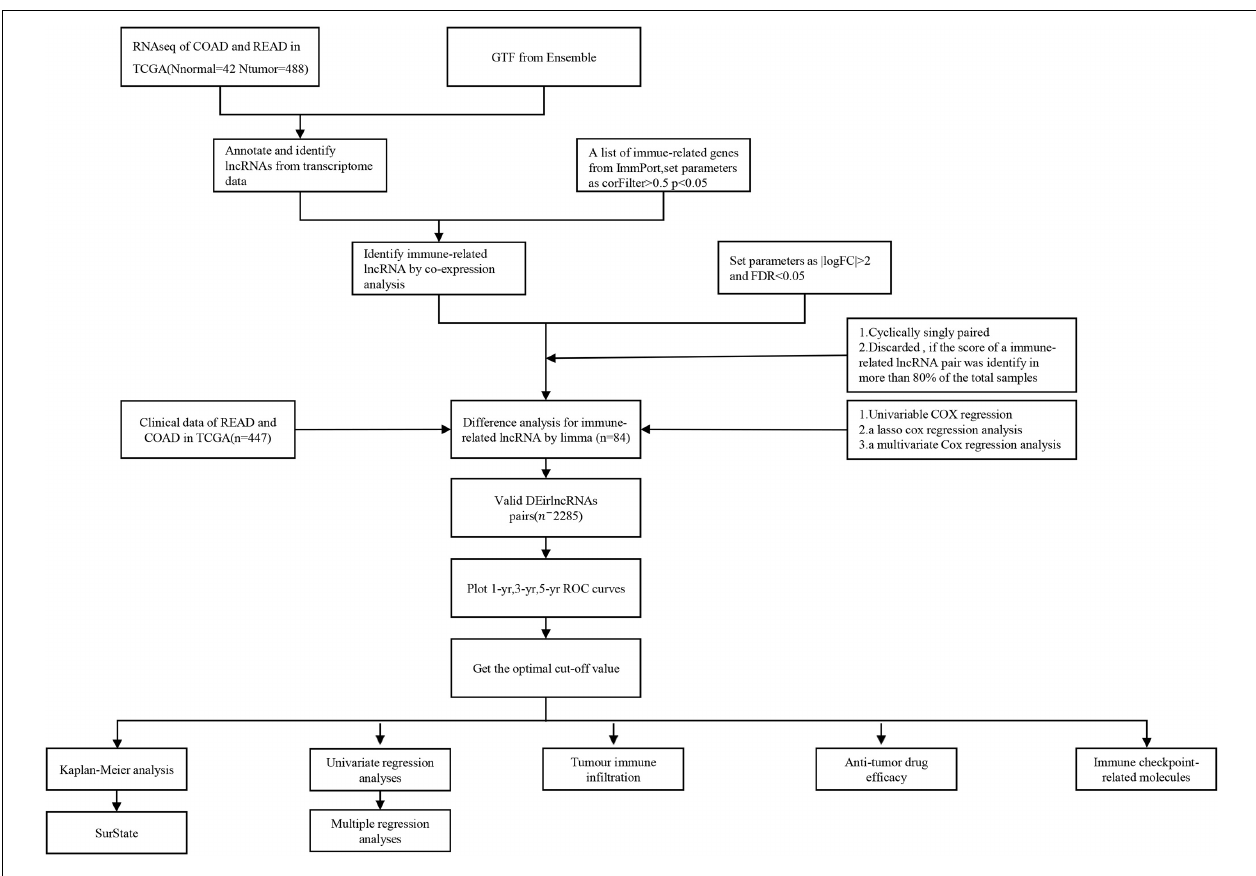
FIGURE 1 | The flow diagram of the systematic study